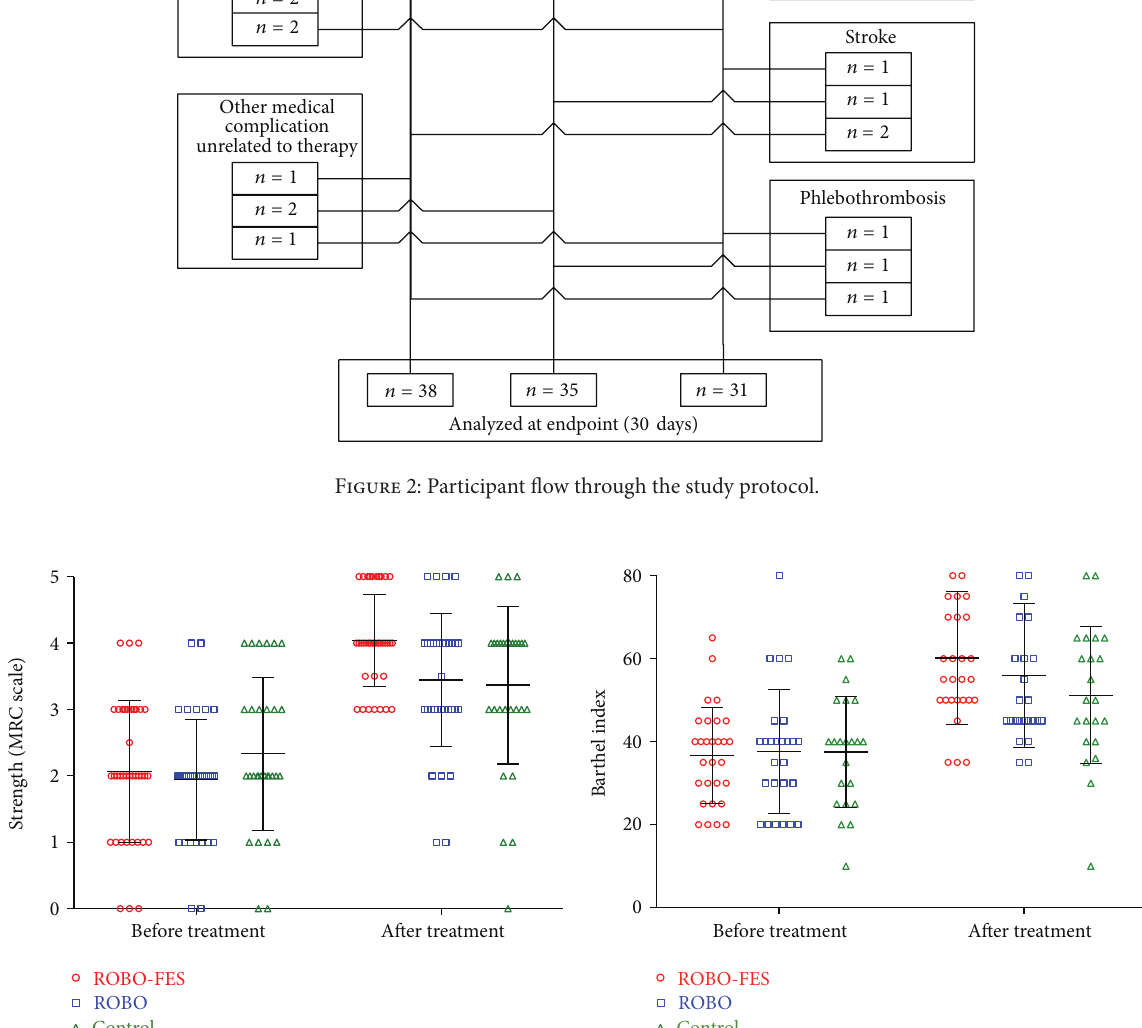
Figure 3: Changes in leg strength measured by the MRC scale (a) and Barthel index (b) over the course of treatment. Strength gains were significantly higher in ROBO-FES and ROBO as compared to control. Effects of group on the Barthel index did not reach statistical significance. Error bars indicate standard